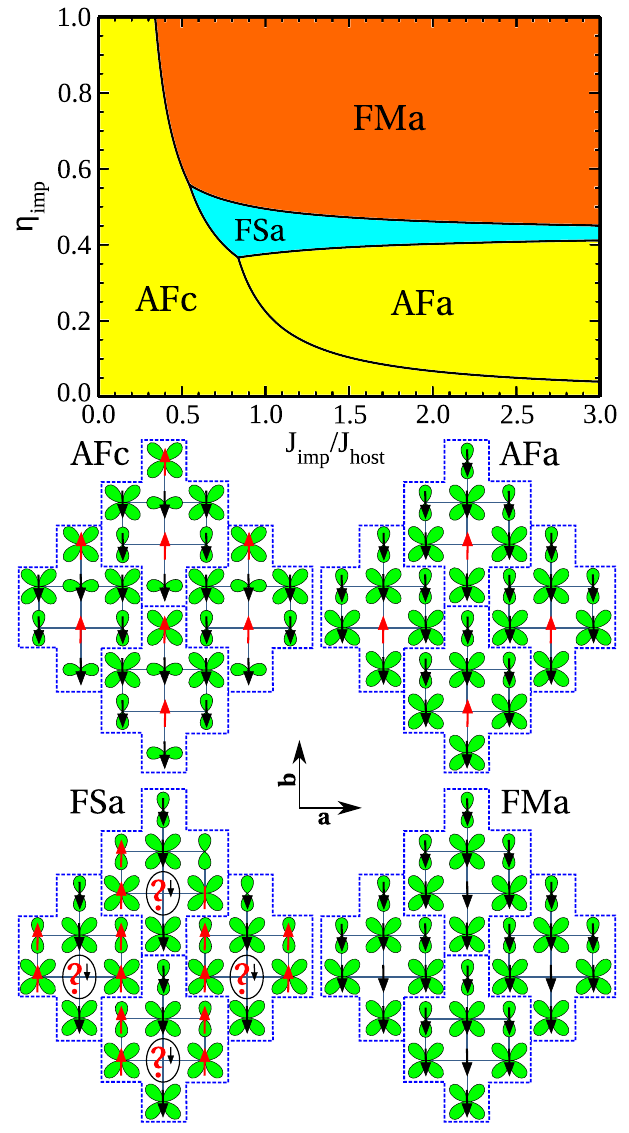
FIG. 9. Top panel: Ground-state diagram obtained for periodic 3 d doping x ¼ 1 = 8 .Differentcolorsrefertolocalspinorderaround the impurity: AF a , AF c , FS a , and FM a . Bottom panel: Schematic view of the ground-state configurations within the four eight-site unit cells (indicated by dashed blue lines) for the phases shown in the phase diagram. The question marks in the FS a phase indicate frustrated impurity spins within the classical approach — the spin direction (small arrows) is fixed only by quantum fluctuations. The 3 d atoms are placed at the sites where orbitals are